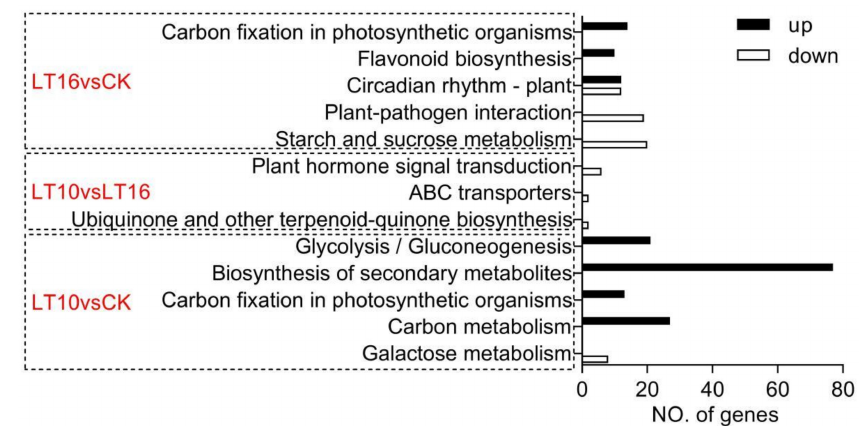
Figure 2. Kyoto Encyclopedia of Genes and Genomes (KEGG) pathways representation for banana ( Musa spp. AAA cv. Baxijiao) upon mild and moderate chilling stress (corrected p ≤ 0.05). The x-axis indicates the number of a specific category of genes in the main term. The y-axis shows the names of functional categories. CK; the control, LT10; low temperature (LT) of 10 ◦ C, LT16; LT of 16 ◦ C.